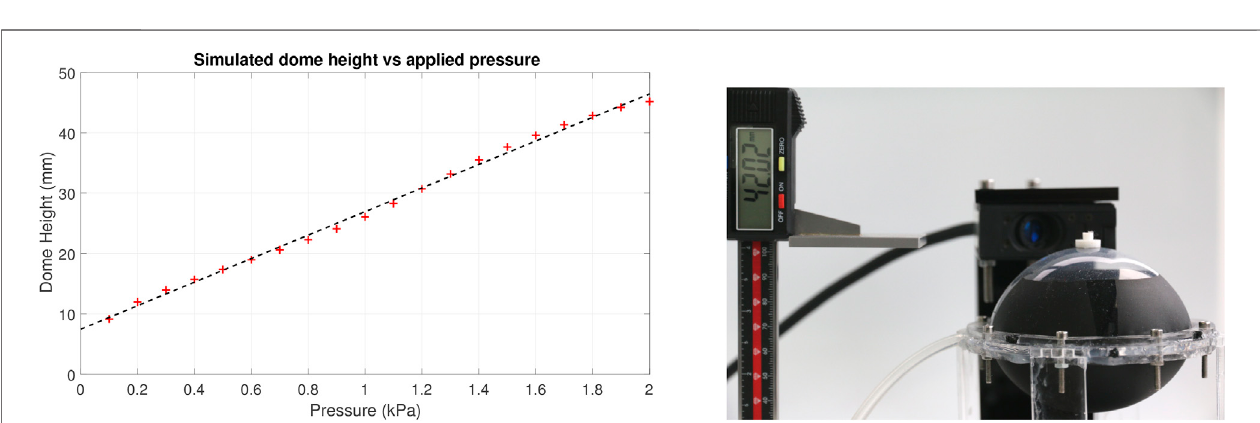
FIGURE 10 | Left: FEM simulated dome height against internal pressure, linear fi t. Right, experimental set-up showing the dome height measurement, tracking marker on the end effector, and the laser displacement sensor head in the rear.